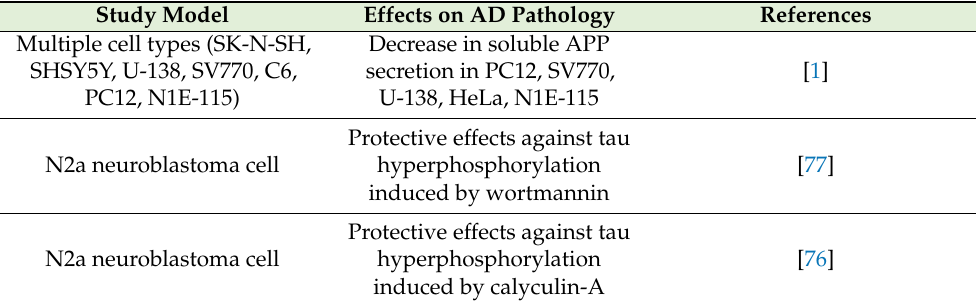
Table 2. In vitro studies related to the neuroprotective effects of melatonin in AD. Abbreviations: C6, Rat glial cell; HeLa, Immortal human cell line; N1E-115, Mouse neuroblastoma cell line; PC12, Rat pheochromocytoma cell line; sAPP, Soluble derivates of Amyloid-beta precursor protein; SHSY5Y, Human neuroblastoma cell line; SK-N-SH, Human neuroblastoma cell line; SV770, Monkey kidney cell line; U-138, Human astrocytic cell